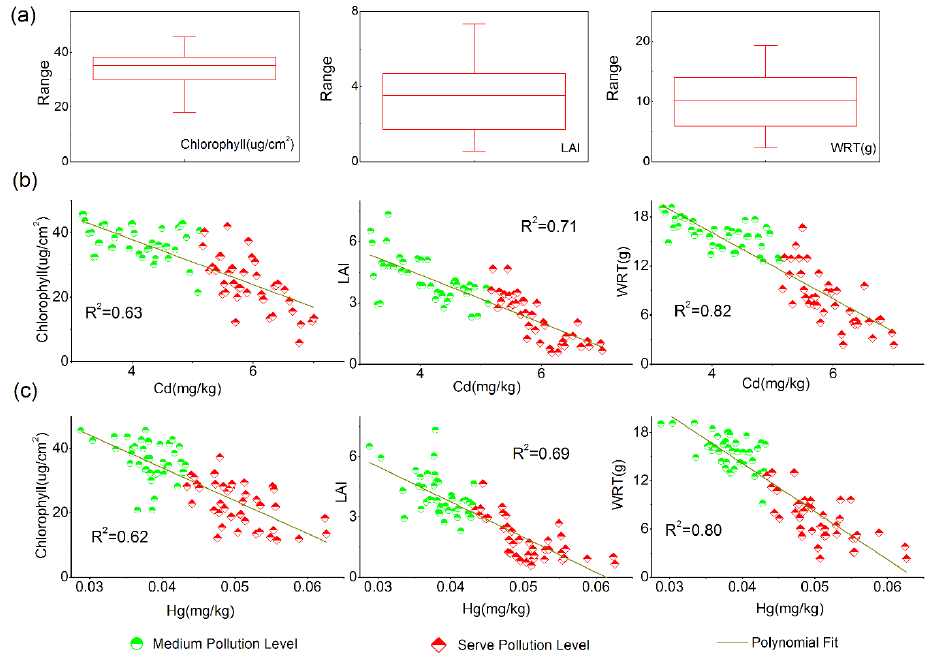
Figure 4. ( a ) Statistics for chlorophyll (μg·cm − ²), leaf area index (LAI), and dry weight of roots (WRT) (g) from field measurements; ( b ) The correlation between Cd concentrations and the